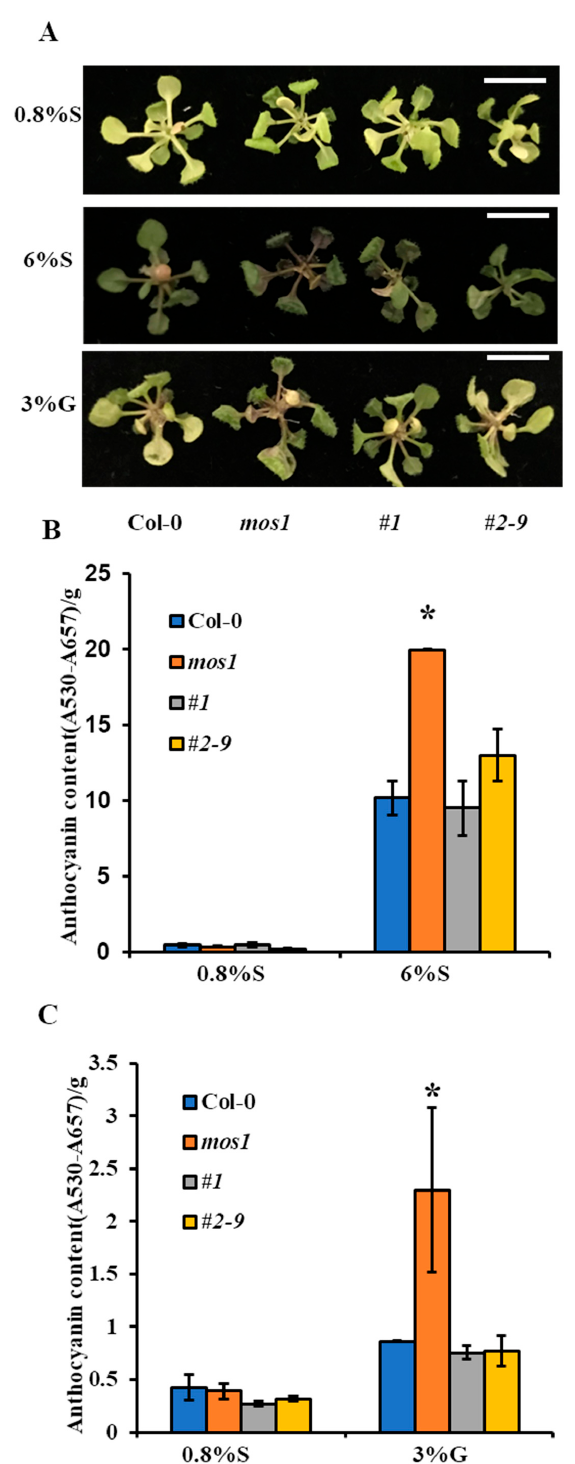
Figure 4. Anthocyanin accumulation induced by sugar in di ff erent lines. ( A ) Representative images of phenotypes of Col-0 and mos1 , #1 , and #2–9 grown on half-strength MS medium with 0.8% sucrose (S), 6% S, or 3% G. Scale bars = 1 cm. ( B ) Anthocyanin content in the seedlings of Col-0 and mos1 , #1 , and #2–9 grown on half-strength MS medium with 0.8% S or 6% S. ( C ) Anthocyanin content in the seedlings of Col-0 and mos1 , #1 , and #2–9 grown on half-strength MS medium with 0.8% S or 3% G. Error bars indicate SE of two independent biological replicates. The asterisks indicate significant di ff erences compared with Col-0 under the same treatment (one-way ANOVA / Bonferroni p <